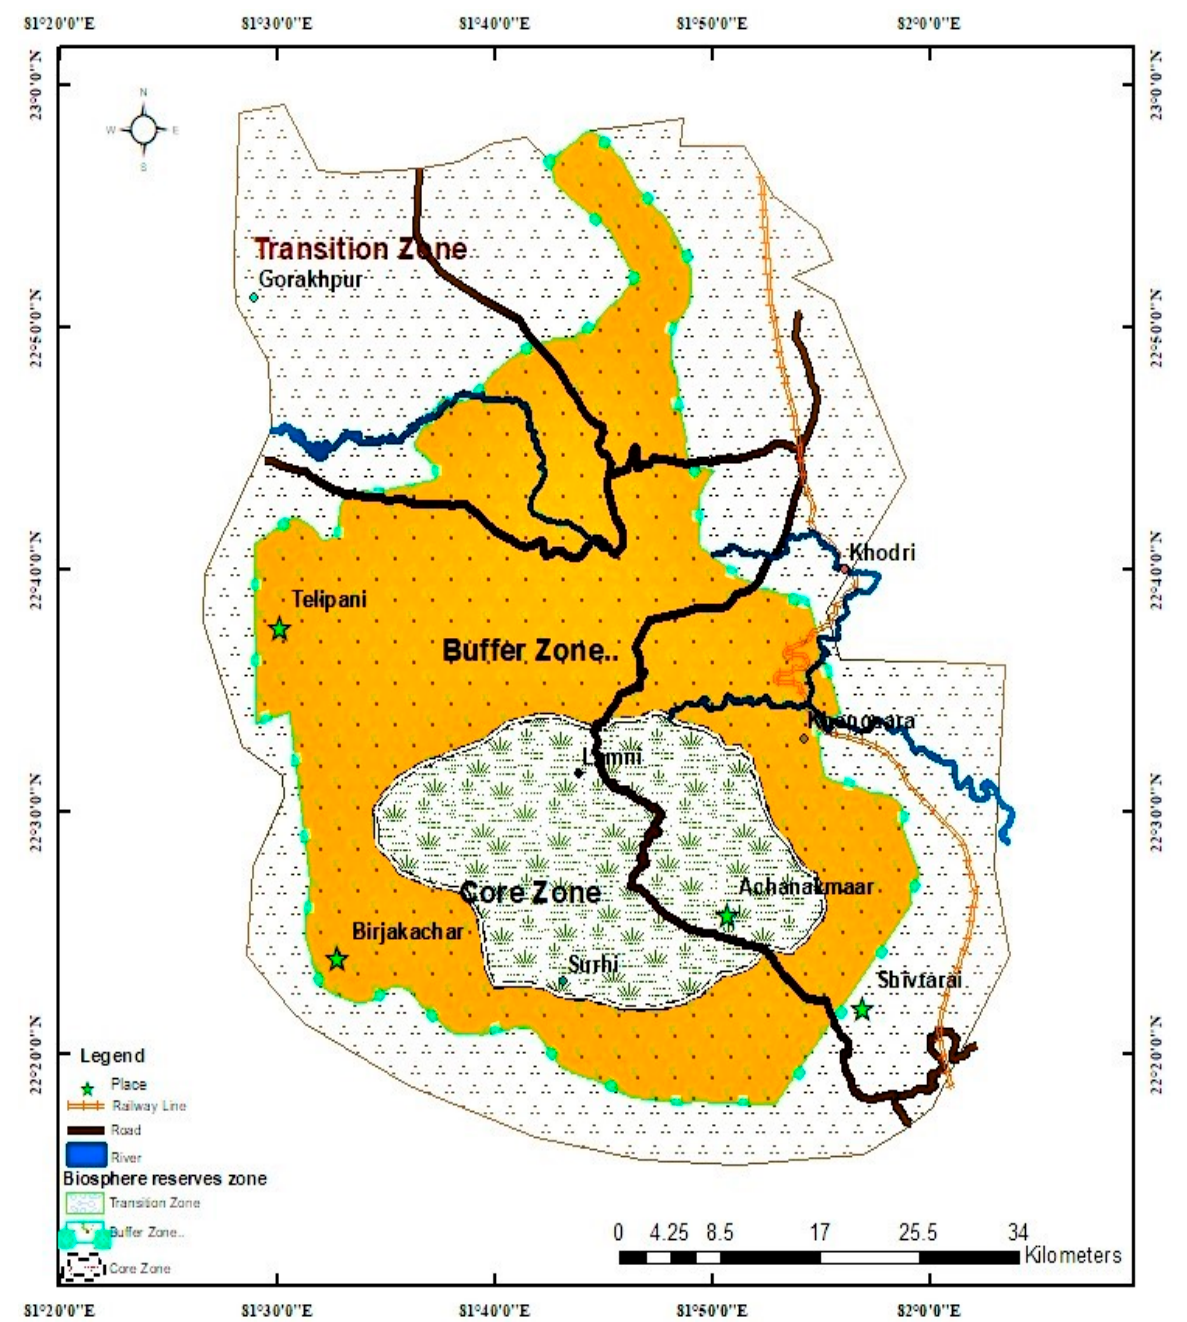
Figure 1. Location of sampling villages in Achanakmaar Amarkantak Biosphere Reserve (AABR) of Central India.